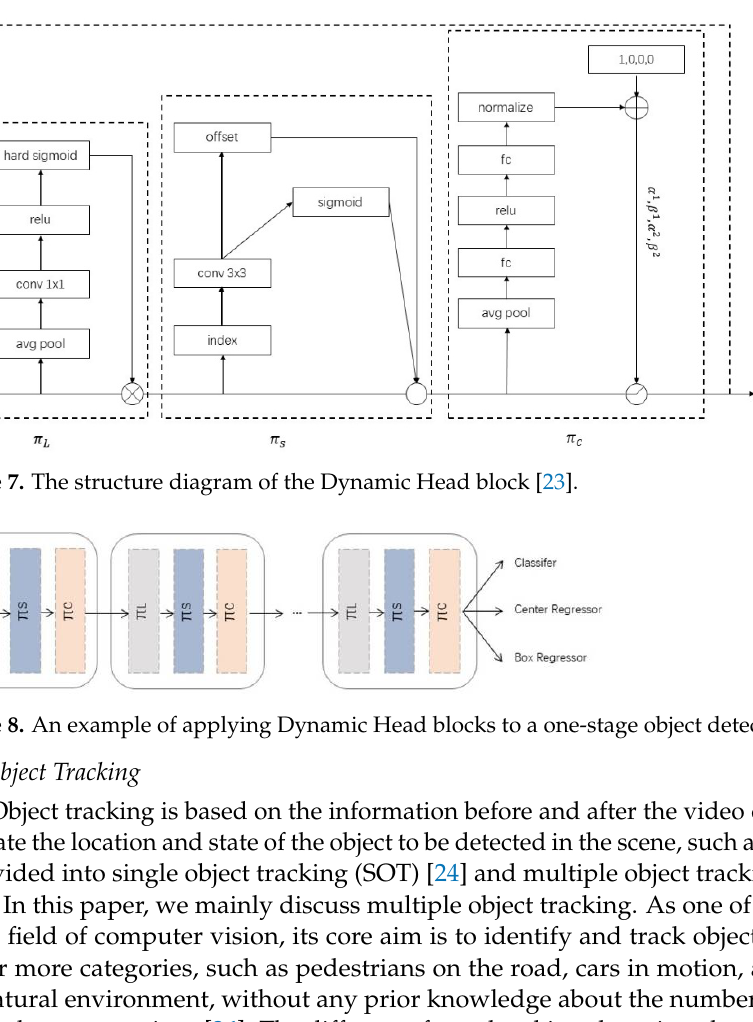
Figure 8. An example of applying Dynamic Head blocks to a one-stage object detector [23].